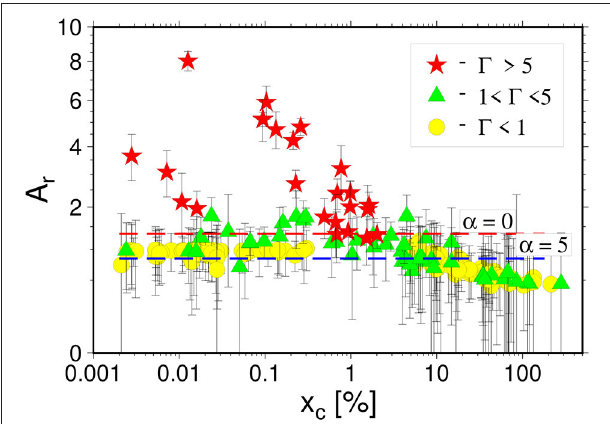
FIGURE 17 | The ratio A r of the maximum of elastic energy released during the final failure to the product of maximum of elastic energy increase rate and x p against x . Horizontal lines shows the prediction of the FBM model for power distribution with α = 0—red line and α = 5—blue line. Errors are mainly due to imprecise estimation of x p and E max . The plotted values have been divided into three groups depending on the value of Ŵ expressing the retardation of the energy maximum x m with respect to x c (see Equation 17): the maximum of energy just follows the x c point ( Ŵ < 1), intermediate case (1 < Ŵ < 5) and the case when the energy maximum occurs far away from x c